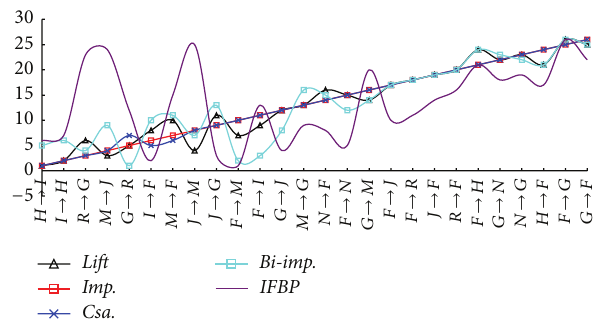
Figure 2: Evaluation results of these five kinds of measure methods ( Lift , Imp ., Csa ., and N-Imp ., IFBP